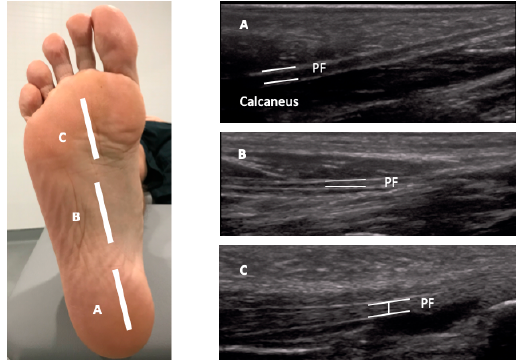
Figure 1. Ultrasound imaging thickness for the plantar fascia at the insertion, midfoot and forefoot locations in an individual with Achilles tendinopathy (AT). Abbreviations: PF, plantar fascia.